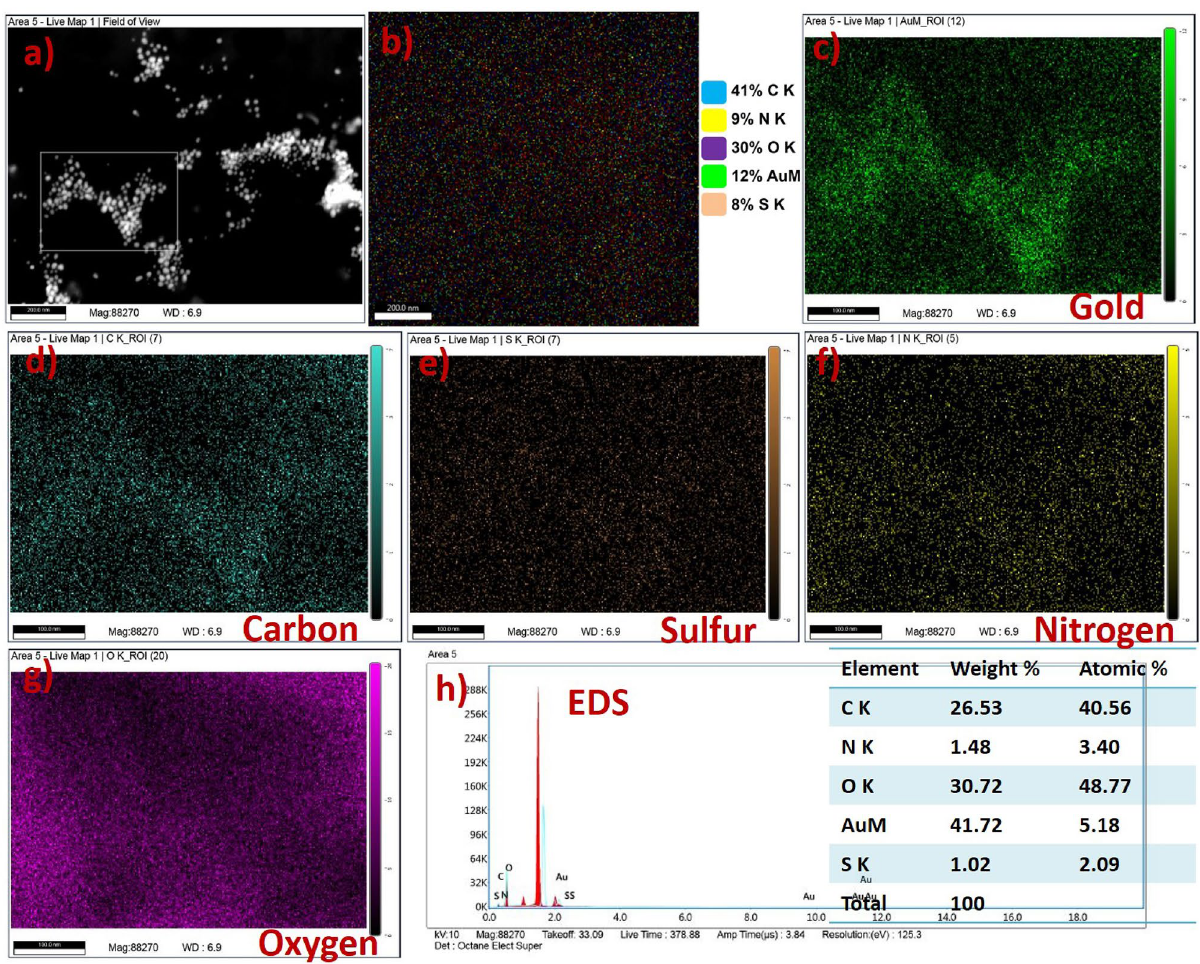
Figure 6. FESEM image and Elemental mapping with EDS spectrum of gold nanoformulations, ( a ) high magnification image gold nanoformulations with selected area for mapping analysis, ( b ) Elemental mapping images of gold nanoformulations with corresponding elements (C K = 41%, N K = 9%, O K = 30%, AuM = 12% and S K = 8%), ( c ) mapping image of metallic gold nanoparticles, ( d ) carbon, ( e ) sulfur, ( f ) nitrogen, ( g ) oxygen and ( h ) EDS spectrum of gold